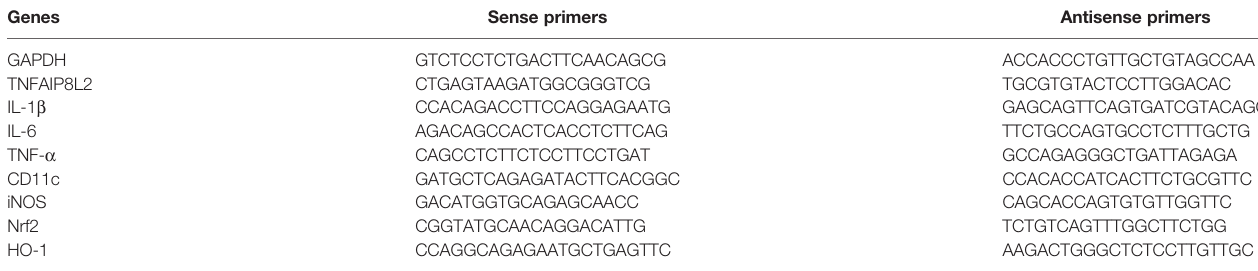
TABLE 1 | Primer sequences for real time PCR.